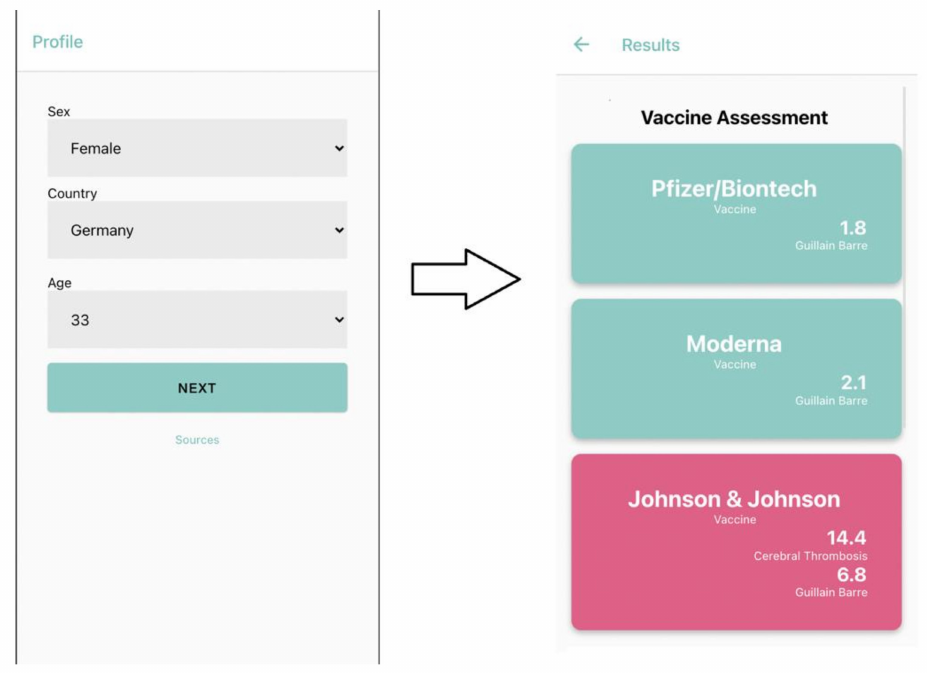
Figure 3. Integration of the statistical analysis into a freely available web application (screenshot shown), enabling the identification of a preferred vaccine based on one’s personal